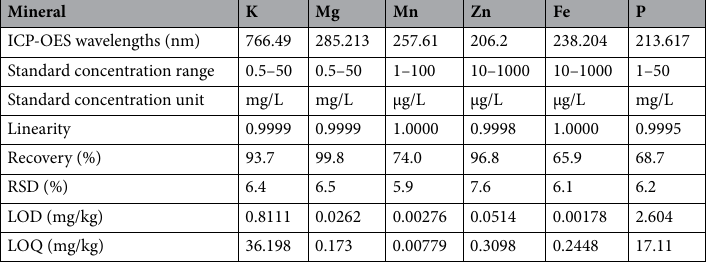
Table 1. Detection and quantification parameters of wheat minerals by